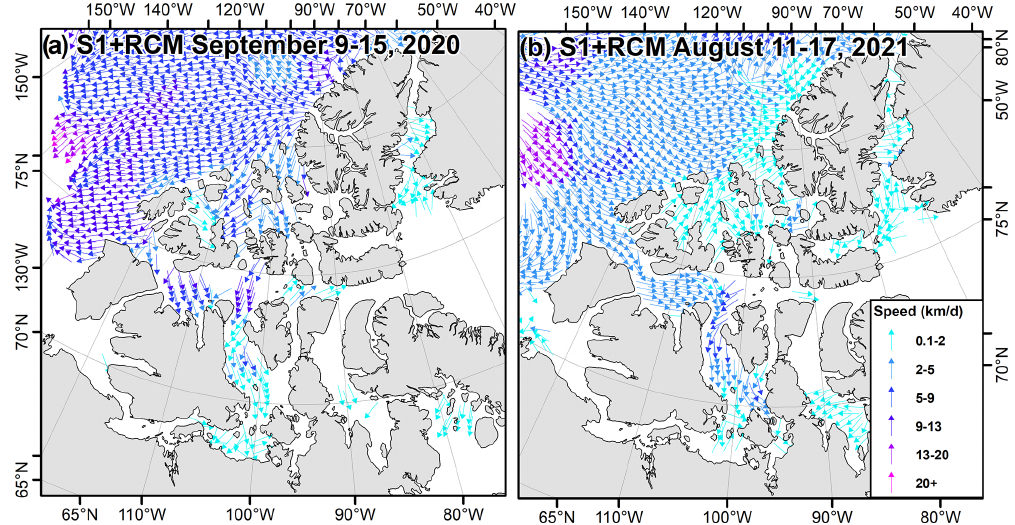
Figure 13. The spatial distribution of 25km 7d S1 + RCM sea ice motion surrounding the Canadian Arctic Archipelago on (a) 9–15 Septem- ber 2020 and (b) 11–17 August 2021. Note that the white areas in the figure indicate either zero ice motion for the landfast ice or no ice motion information extracted (because of no SAR data, no ice, or no stable ice